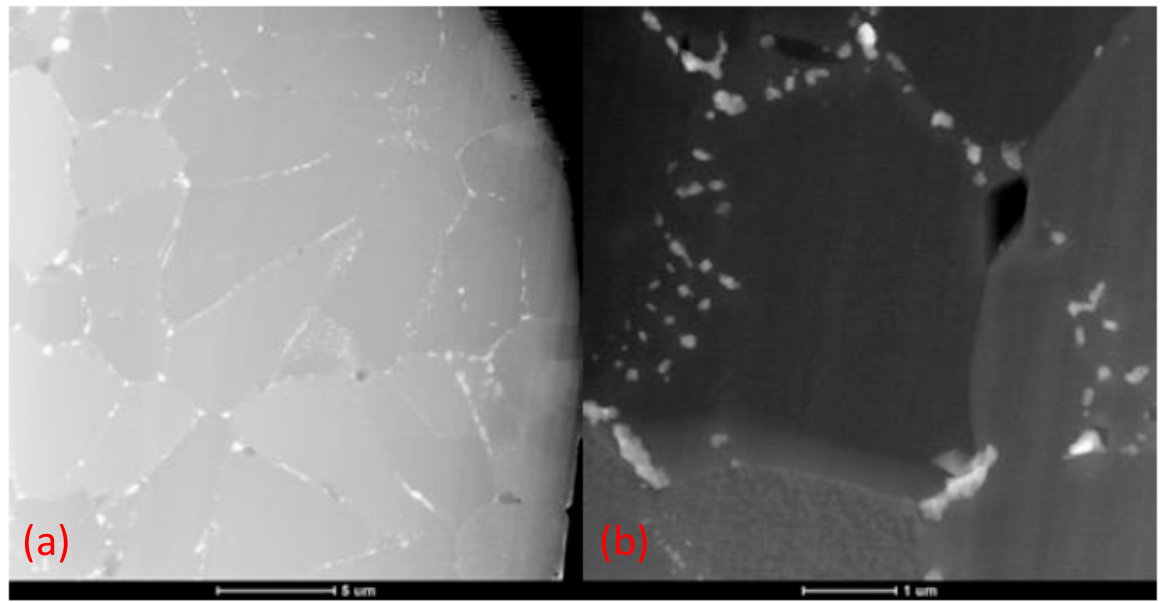
Figure 11. ( a ) A HAADF-STEM micrograph of a thermally pre-processed and gas-atomized Al 6061 powder particle was heat-treated at 540 °C for 60 min and prepared by FIB milling and polishing. ( b ) A higher magnification HAADF-STEM micrograph of the heat-treated Al 6061 gas-atomized powder particle wherein precipitates and intermetallic phases along the sub-grain boundaries can be observed. Note that the scale bar associated with ( a ) is 5 μ m while the scale bar associated with ( b ) is 1 μ m.